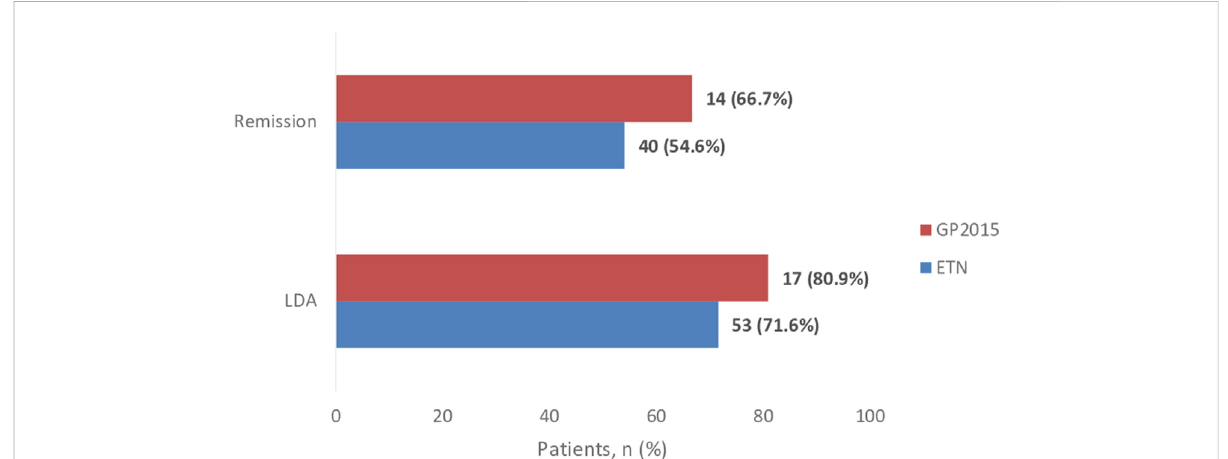
FIGURE 2 Proportionofpatientsachievingremissionde fi nedasDAS28-CRP ≤ 2.6andlow-diseaseactivityscore(LDAS)de fi nedasDASR28-CRP ≤ 3.2.The rate of patients who achieved remission at week 52 were 40 (54.6%) and 14 (66.7%), p -value = 0.303, in the ETN and GP2015 group, respectively. Fifty-three (71.6%) patients in the ETN group and 17 (80.9%) in the GP2015 group ( p value = 0.391) achieved